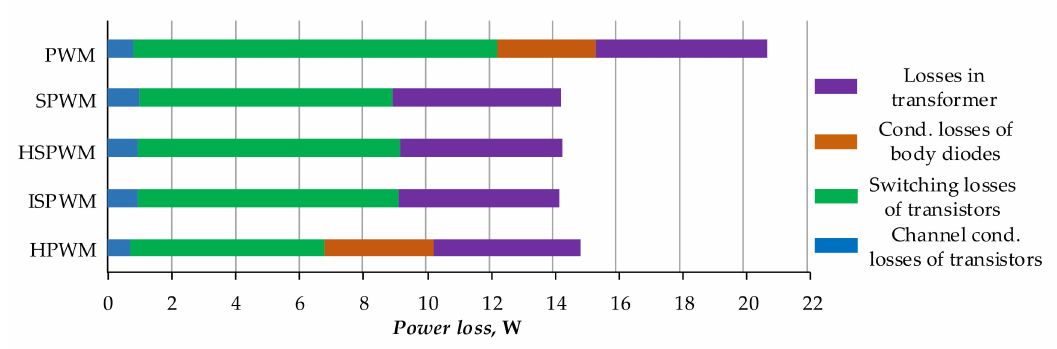
Figure 6. Diagram of the power losses in the SRC at V in = 50 V, P = 200 W for di ff erent PWM methods.